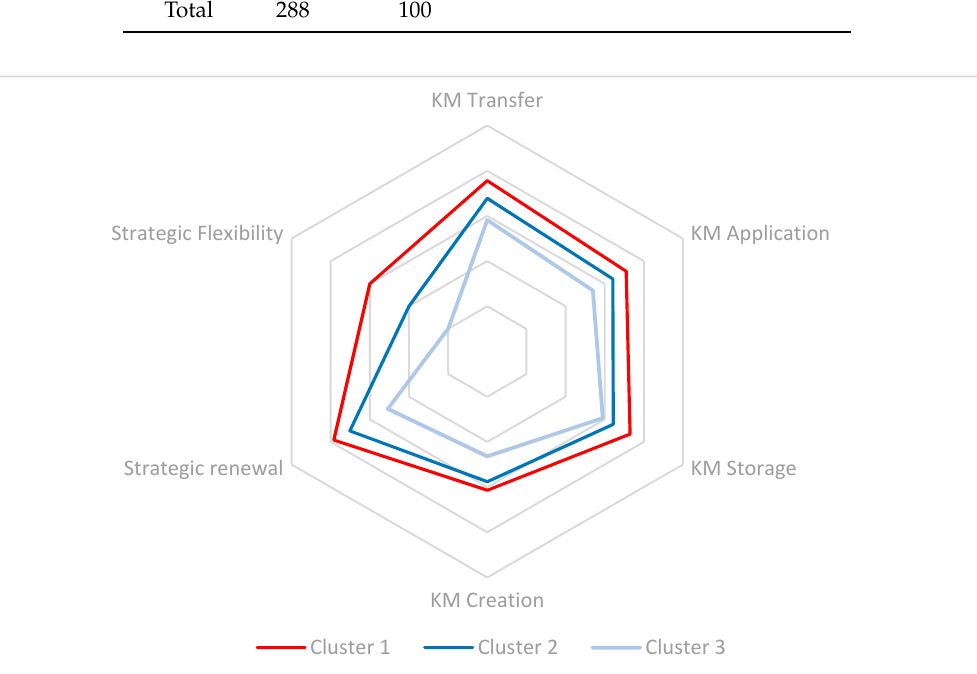
Figure 1. Two-step clustering analysis results.